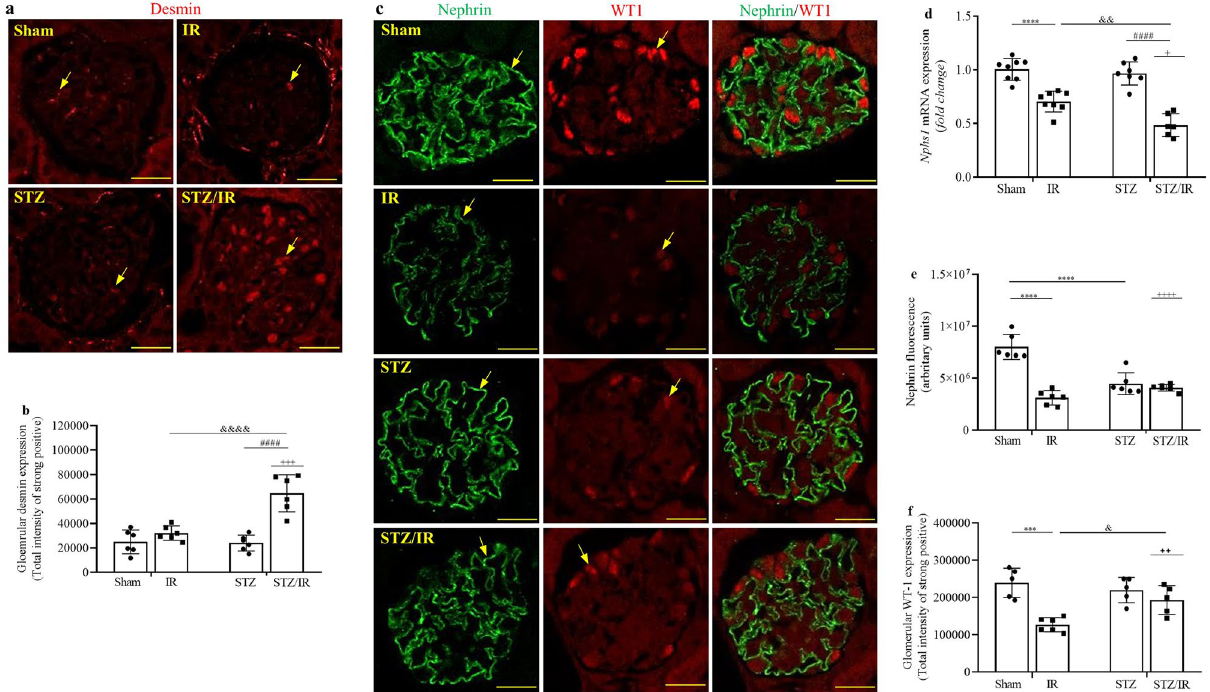
Figure 2. Effect of renal ischemia/reperfusion in vehicle- and STZ-treated mice on desmin staining ( a , b ), nephrin and WT1 staining ( c ) and Nphs1 (nephrin) mRNA expression ( d ). The averages of the fluorescence intensities for the nephrin and WT1 proteins are also represented ( e , f respectively). + p < 0.05, ++ p < 0.01, +++ p < 0.001, ++++ p < 0.0001 for the interaction between diabetes and renal IR (STZ/IR), as indicated by two- way ANOVA (Supplementary Table S2). The Bonferroni post hoc test was also performed: ***p < 0.001, ****p < 0.0001 vs sham group; #### p < 0.0001 vs STZ group; & p < 0.05, && p < 0.01, &&&& p < 0.0001 vs IR group. The values are the mean ± S.D. (n = 5–8). Immunofluorescence images were captured using a Zeiss LSM 510 confocal microscope equipped with a 63 × objective and laser excitation at 488 or 543 nm. The fluorescence intensity